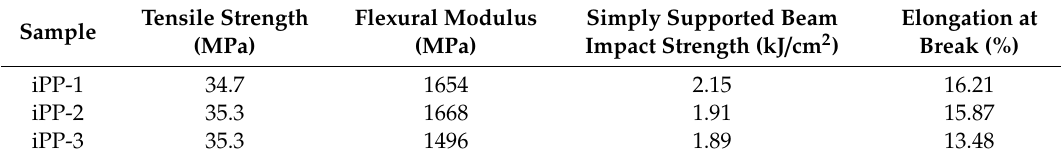
Table 4. Mechanical properties of the iPP samples.